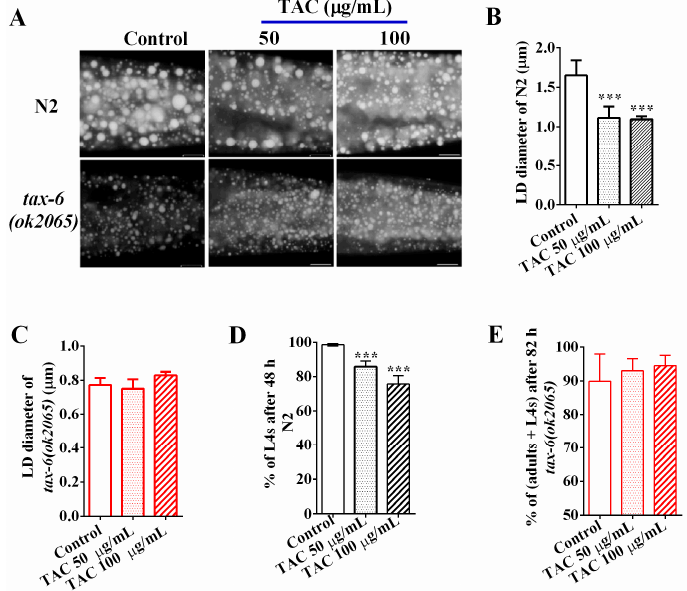
Figure 2. Tacrolimus (TAC) decreases fat accumulation via calcineurin. ( A ) Nile Red staining of fixed worms treated with different concentrations of tacrolimus (TAC). Representative animals are shown with stained lipid droplets (LDs) in the posterior region. In all of the represented animals, the anterior is indicated on the left and the posterior is indicated on the right. Scale bar represents 10 μ m; ( B ) The average size of the lipid droplet (LD) in N2 were measured from Nile Red staining of fixed worms from ( A ). n = 10 for each worm strain; ( C ) The average size of the lipid droplet (LD) tax-6(ok2065) were measured from Nile Red staining of fixed worms from ( A ). n = 10 for each worm strain; ( D ) the growth of wild type N2 upon tacrolimus (TAC) treatment or not; and ( E ) The growth of tax-6(ok2065) upon tacrolimus (TAC) treatment or not. Data are presented as the means ± SD. * indicates significant difference between worms treated with and without tacrolimus (TAC), *** p < 0.001. n > 150 worms.